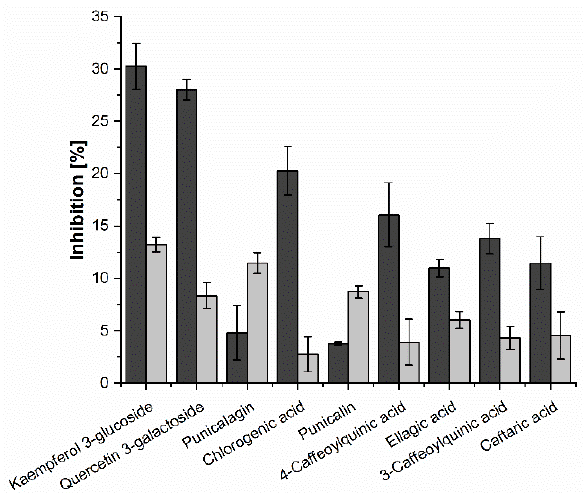
Figure 5. Inhibition (%) of α -amylase (dark grey) and α -glucosidase (light grey) assay. Results are shown for copigment standards. Bars represent means ± SD ( n = 3).